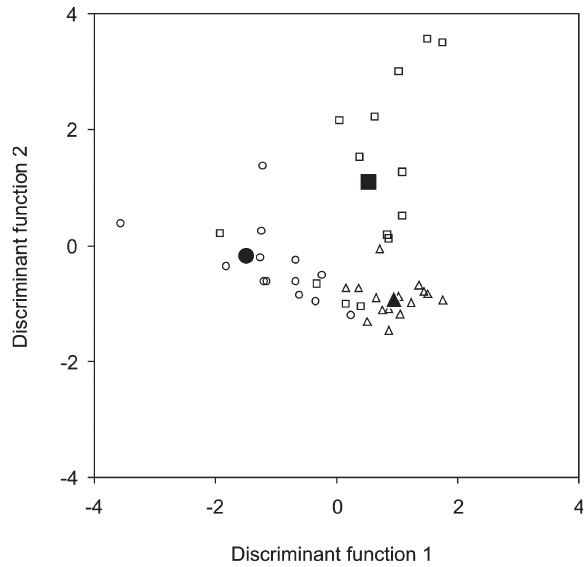
Fig . 2. – Bi-plot of the scores and group centroids for the discri- minant functions 1 and 2 used to discriminate sea lampreys from different river basins ( Å - Guadiana; £ - tagus; r - minho; group centroids are represented by the same symbols in black) based on the fatty acid composition of Pl of muscle. Table 5. – Summary of discriminant loadings and potency index for Pl